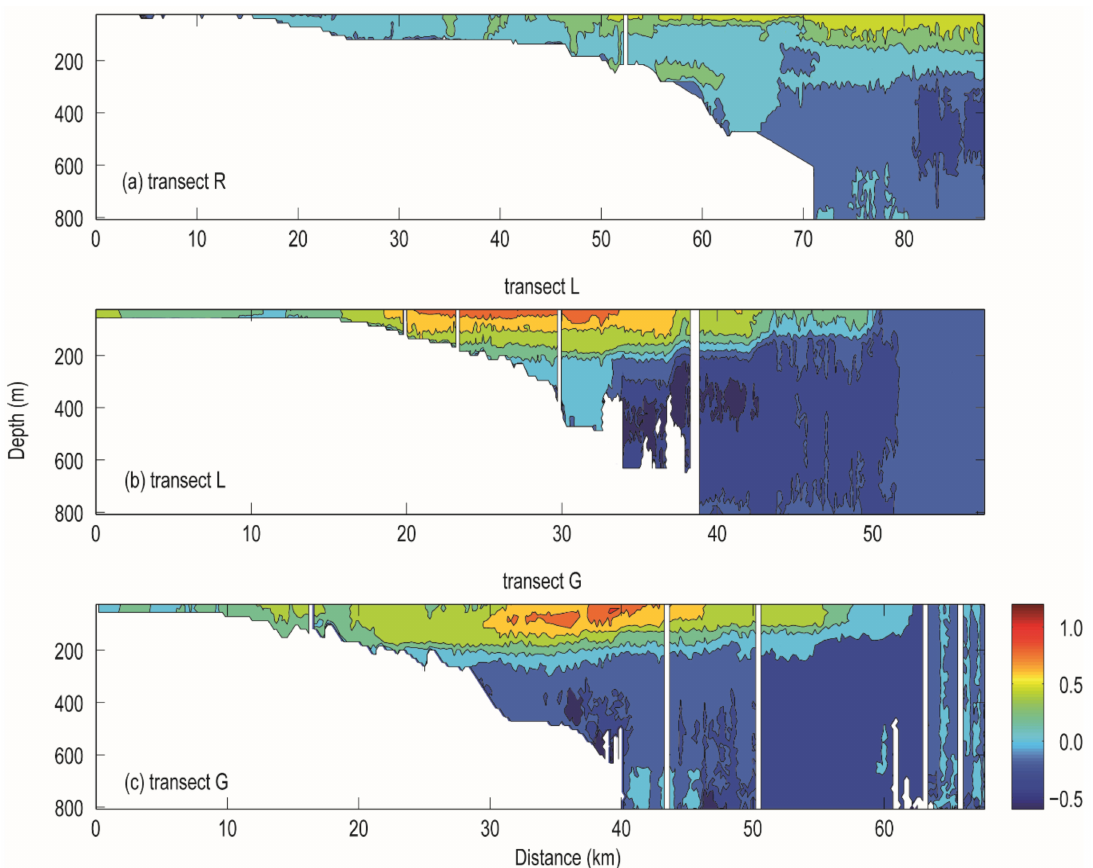
Figure 3. Cross - shelf Acoustic Doppler Current Profiler (ADCP) transects obtained in April 2006 using the RV Southern Surveyor and an RDI 75 kHz ADCP. Locations of transects are shown on Figure 1. Units are ms − 1 . In ( a ) positive values (warmer colors) represent southward flow whist in ( b ) and ( c ) positive values represent eastward